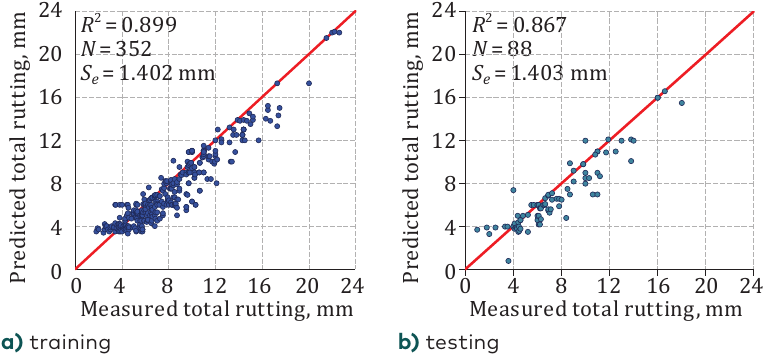
Figure 11. Measured and predicted rutting of NN20